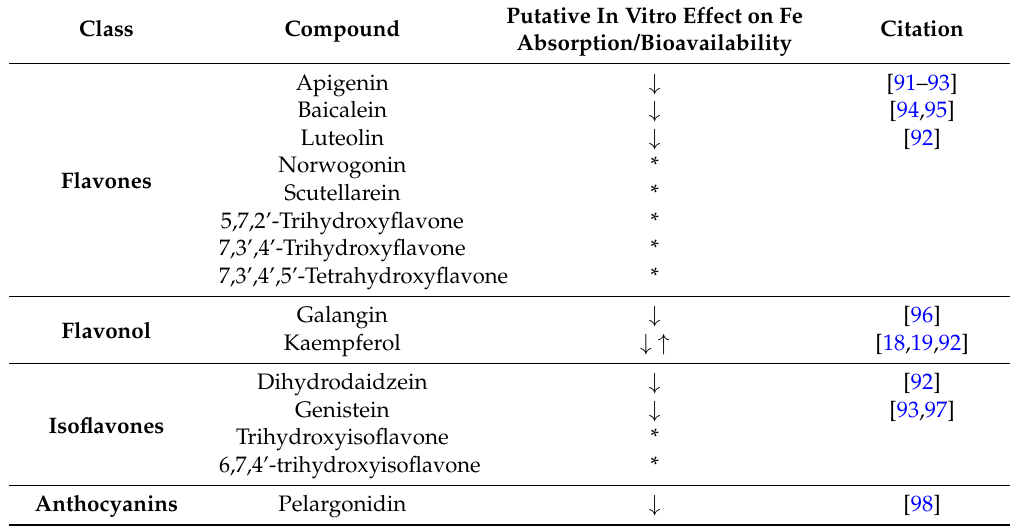
Table 8. Aglycone of polyphenolic compounds corresponding to an m / z = 431.09 highly-enriched in the High-Fe pearl millet